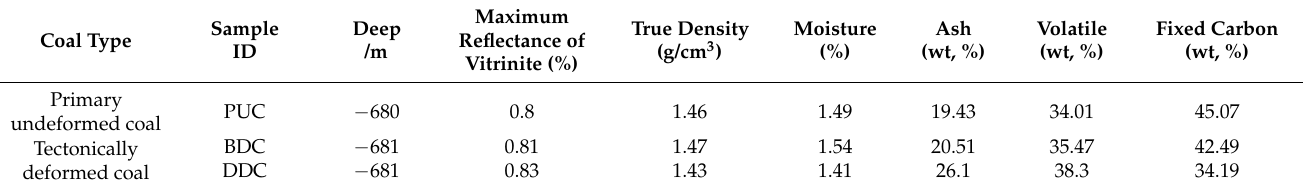
Table 1. Basic information of coal